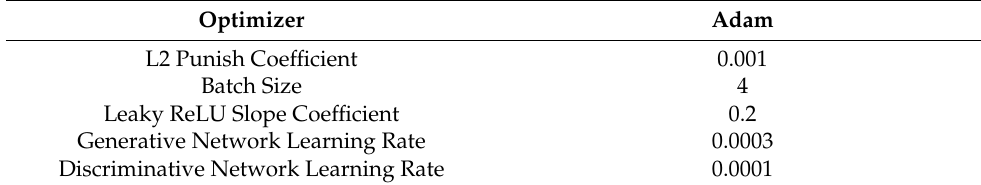
Table 2. Training super parameter